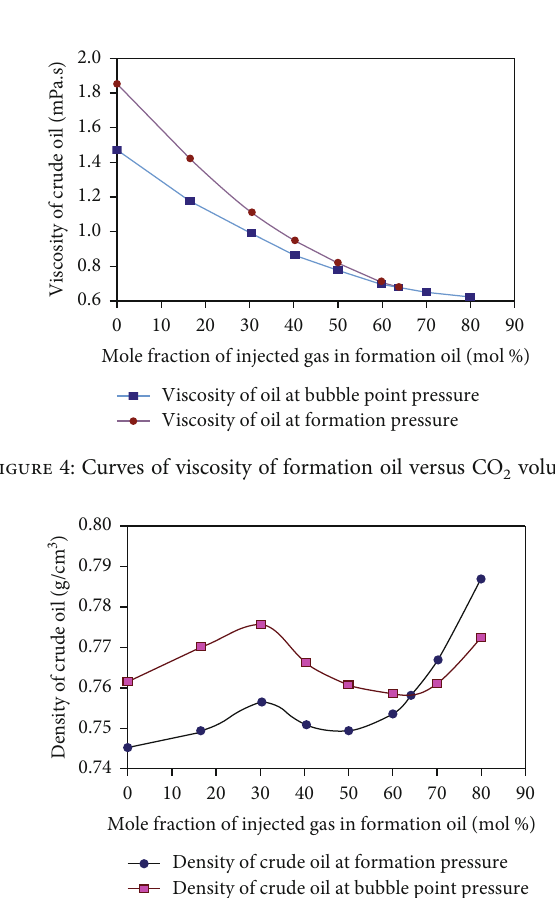
Figure 8: Bitumen precipitation curve of CO volume. 2